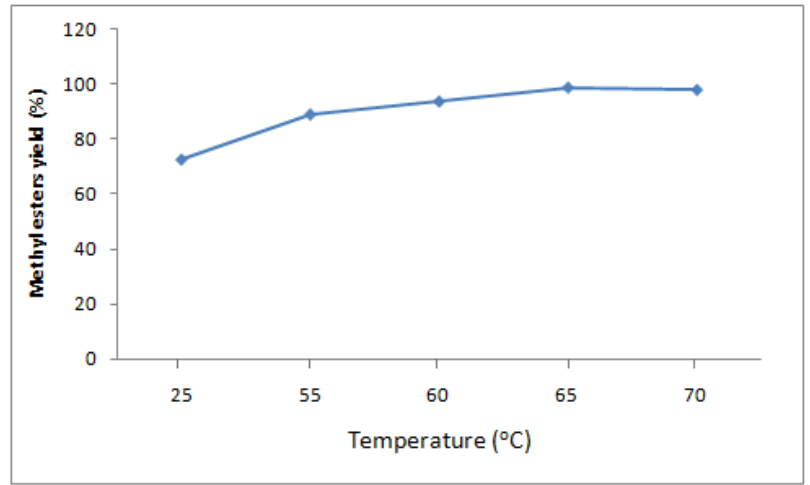
Figure 2. Effect of reaction temperature on yield of methyl esters from coconut oil. (constant catalyst concentration of 1 wt% of oil, molar ratio methanol:oil of 7:1, flow rate 142 mL/min, stirring speed 800rpm, residence time 21.04 min).